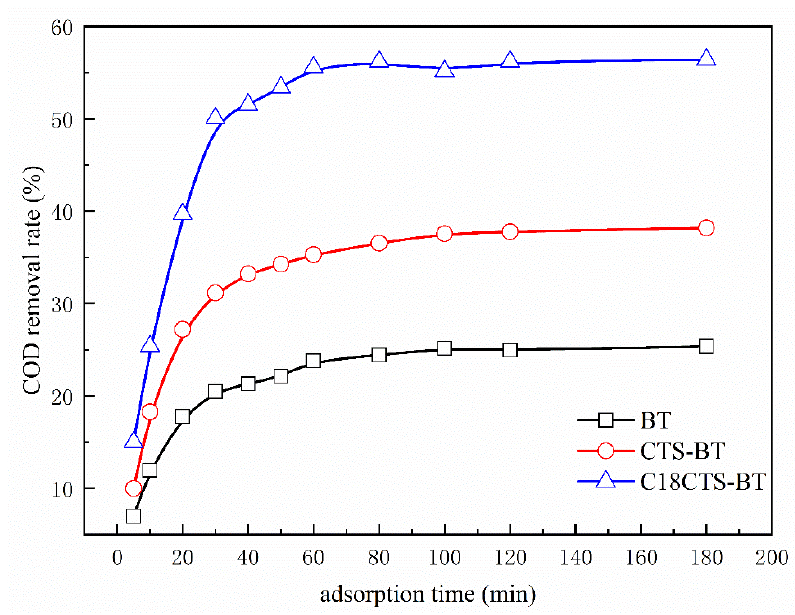
Figure 8. Effect of adsorption time on removal rate of COD (adsorbent dosage is 1.5 g · L − 1 ; pH = 7.0).